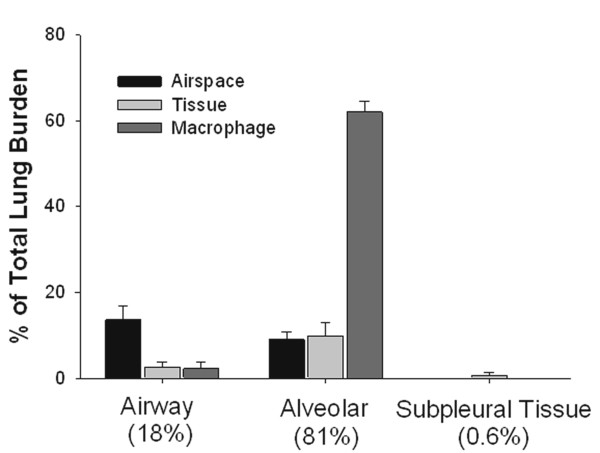
Morphometric determination of the initial lung distribution of MWCNT 1 day post aspiration. Results show the distribution of MWCNT fiber burden in airways, alveolar and subpleural tissue regions of the lungs one day after aspiration. As shown by the different shades of bars, MWCNT fiber burden in the airways and alveolar regions were further subdivided into the airspaces of the region, tissue of the region and macrophages. Results are expressed as a percentage of the total lung burden. (Mean ± SE, N = 7).